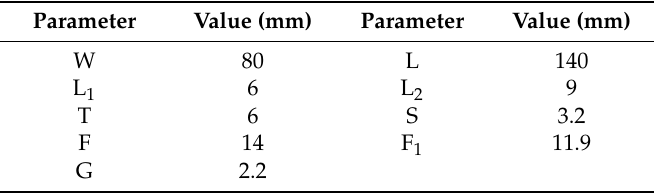
Table 1. Parameters of the proposed